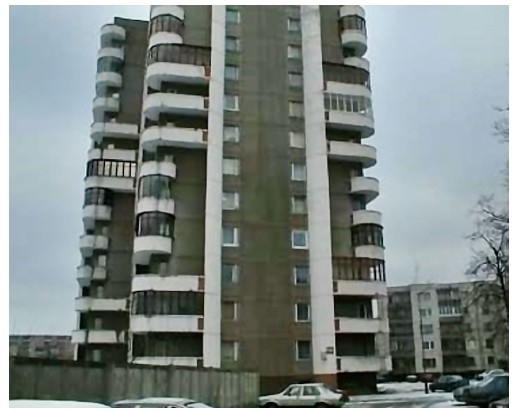
Fig. 2. Multi-storey building at Buivydiskiu st. 15,